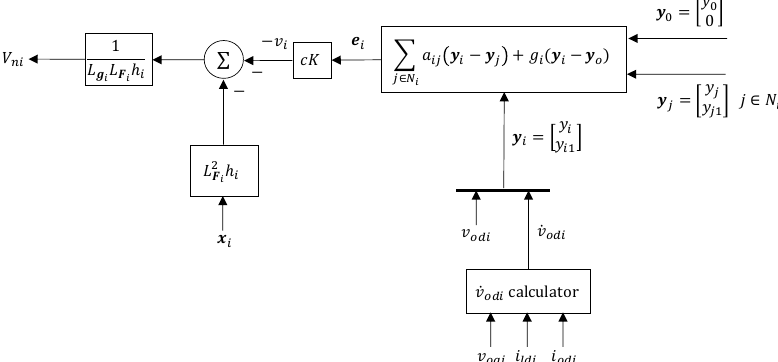
Figure 8. Block diagram of distributed secondary voltage controller [64].